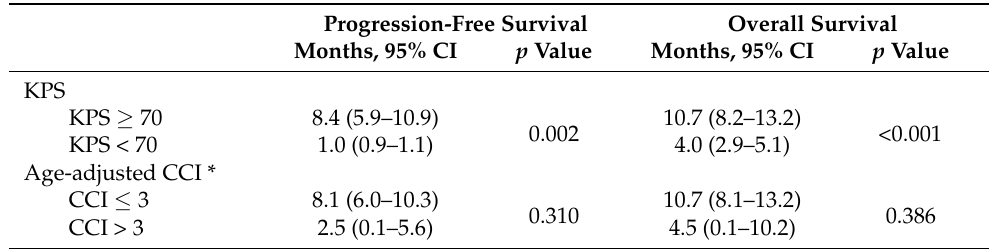
Table 6. Progression-free Survival and Overall Survival according to the Karnofsky Performance Status and Charlson Comorbidity Index.